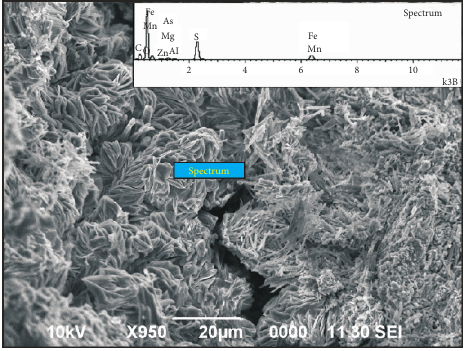
Figure 6: The morphology and composition of fibroferrite (mi- croscope ZEISS EVO 50XVP).